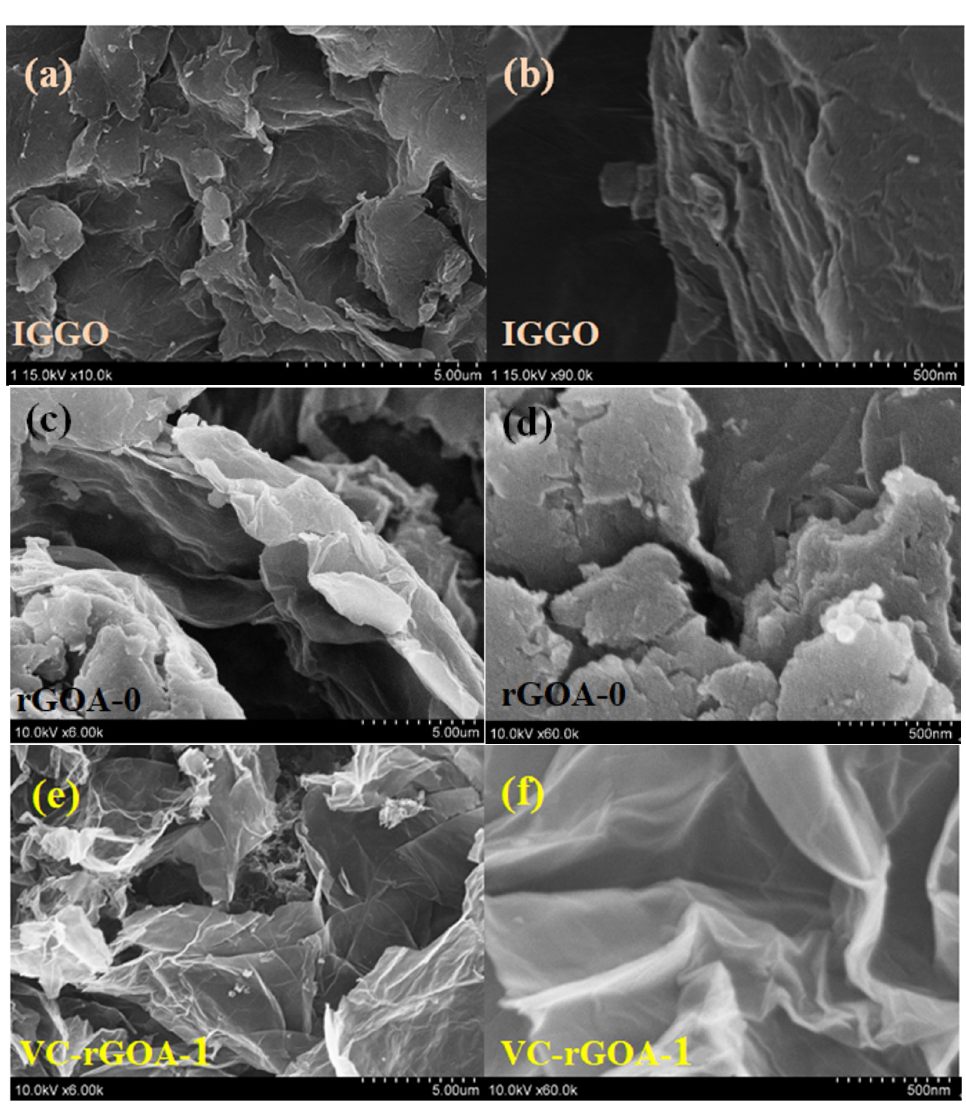
Figure 2. Scanning electron microscopy (SEM) images of IGGO ( a , b ), rGOA-0 ( c , d ), and rGOA-1 ( e , f ). The structures of IGGO, rGOA-0, and rGOA-1 are further analyzed by XRD. The rele- vant XRD patterns (Figure 3) exhibit an significant structural change after the hydrothermal reduction. A typical, strong peak at 2 θ = 11.6 ◦ , is the (001) plane of IGGO, with an interlayer spacing of 7.6 Å. This large distance of interlayer could be linked to the presence of epoxy, hydroxyl, and carboxyl groups [40]. The (001) peak of rGOA-0 decreases, and a faint (002) facet of graphitic carbon appears at 2 θ = 25.3 ◦ [41]. It proves that incomplete reduction occurs on the rGOA-0 nanosheets surface, which agrees with the SEM observations. After the reduction process, the XRD pattern of rGOA-1 has a (002) plane at 2 θ = 25.3 ◦ , suggest- ing ordered graphene layers and yielding a smaller interlayer spacing of 3.6 Å. It could be claimed that due to the removal of the oxygen functionalities, C=C bonds and π – π interactions are restored, reducing the interlayer spacing